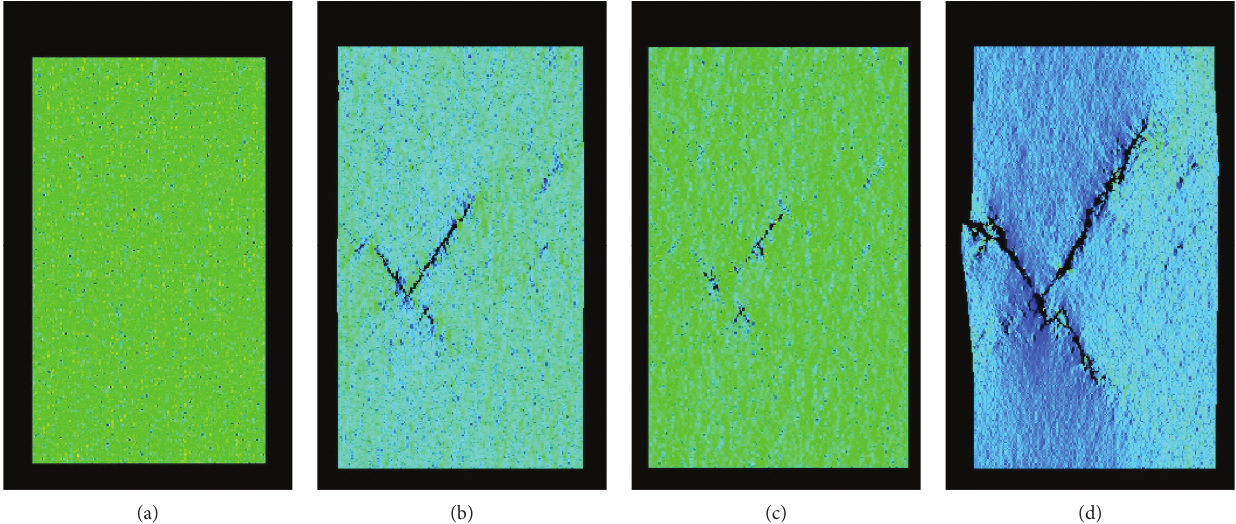
Figure 6: Macroscopic failure of rock mass at the height-to-diameter ratio of